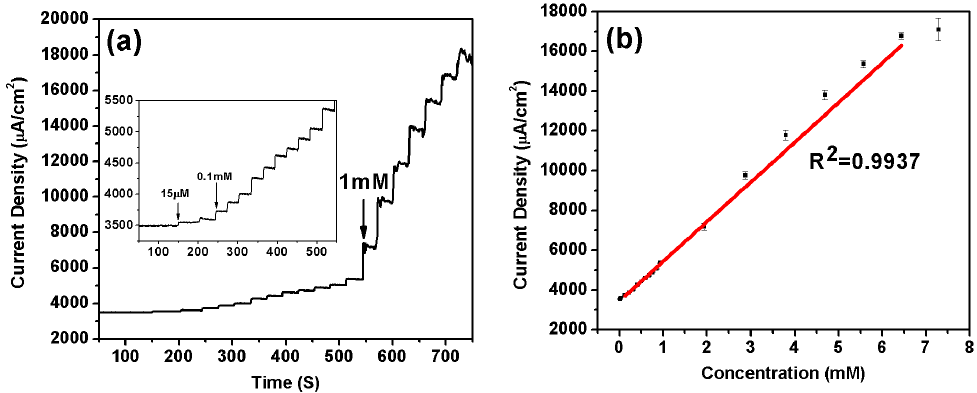
Figure 5. ( a ) Amperometric response of Ni/NiO-Nafion-rGO nanocomposite modified SPE in a series of concentrations of glucose at an applied potential of 0.55 V (insert show the magnification of low glucose concentration); ( b ) Linear calibration curve to the amperometric response. Table 1. Comparison of the performance of nonenzymatic glucose sensors based on graphene and transition metals. CS: Chitosan; NPs: nanoparticles; GCE: glass carbon electrode; ILE: Ionic-liquid electrode; GR: grapheme.